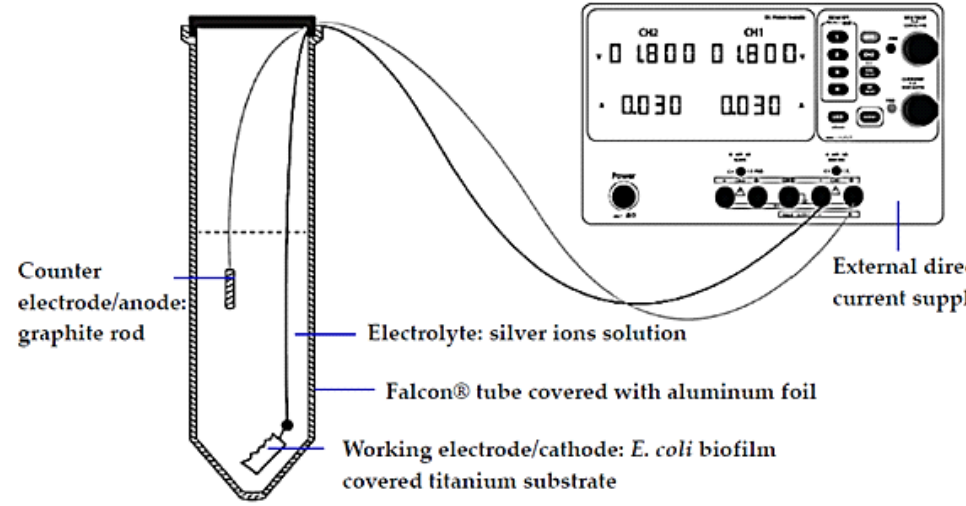
Figure 1. Schematic diagram of the electrochemical cell setup. Table 2. Numbers of viable cells (CFU/mL) of E. coli ATCC 25922 biofilms after the ionic silver treatments (ST-Sxx) and the electrical-enhanced silver treatment (EST-Sxx) with different ionic silver concentration (0.0, 0.4, 0.8, and 1.6 µg/mL) in comparison to the non-ionic and non-electrical treatment (ST-S0.0). The values are expressed as mean ± SD ( n = 3).